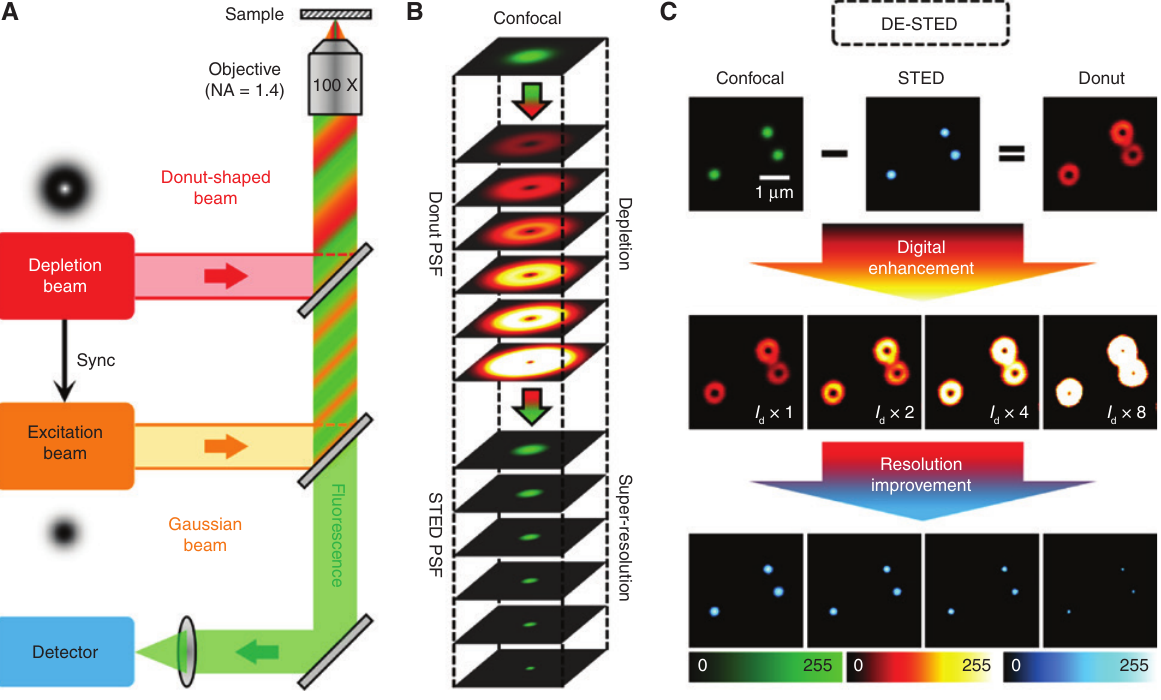
Figure 1: Schematic principle of DE-STED. (A) A sketch of a universal pulsed STED microscope. (B) The simulation of STED superresolution imaging with the increase of the depletion laser power. (C) The principle of DE-STED for achieving resolution improvement in the sample of fluorescent beads with the increase of the enhancement coefficient and without increasing the depletion laser